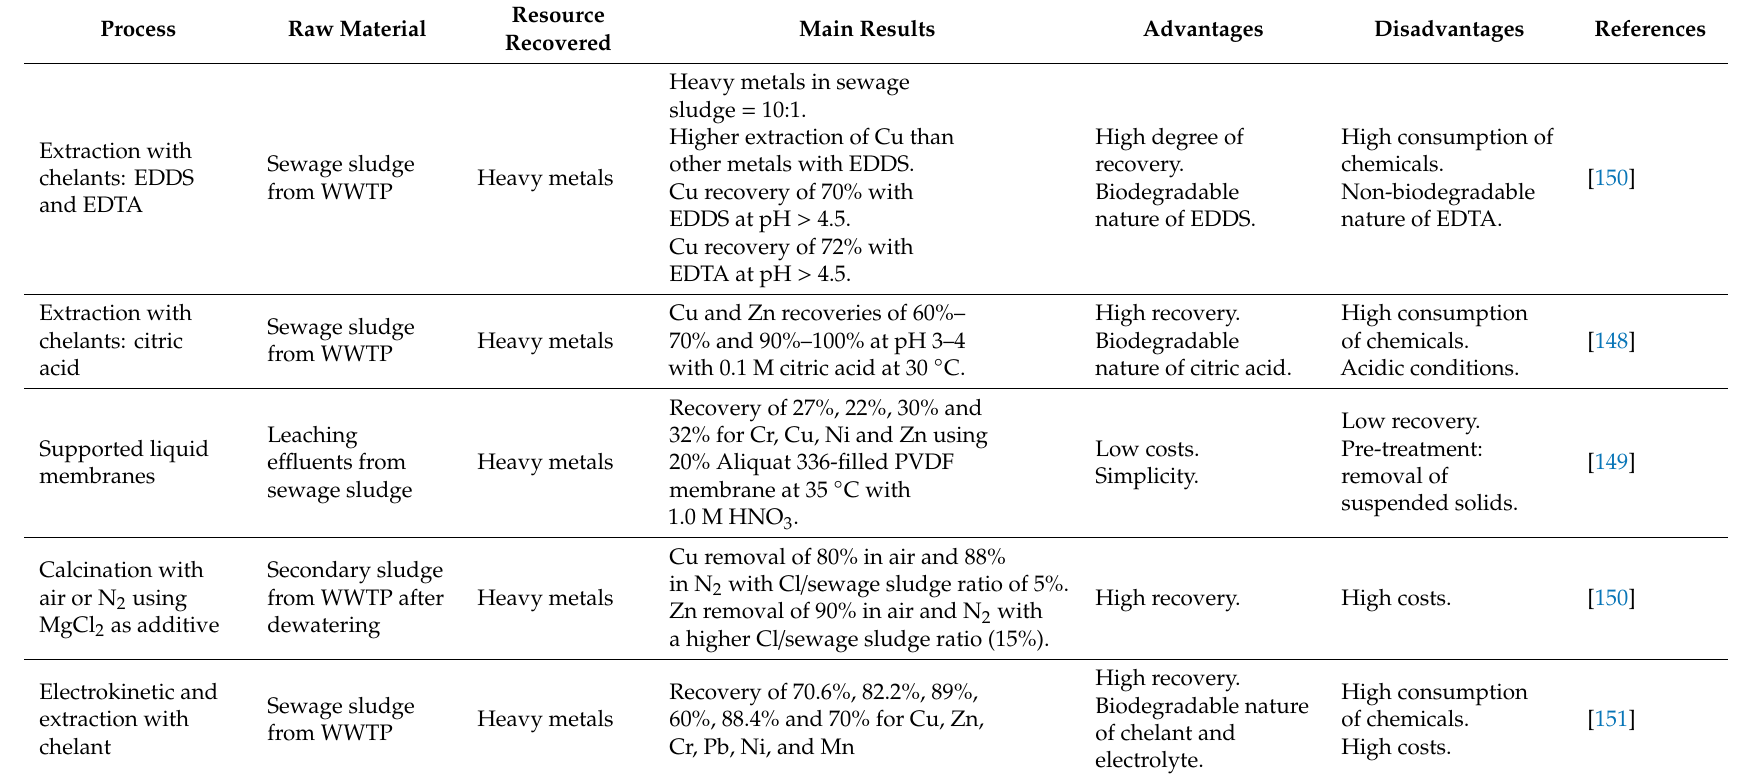
Table 7. The Process employed for heavy metal recovery from sewage